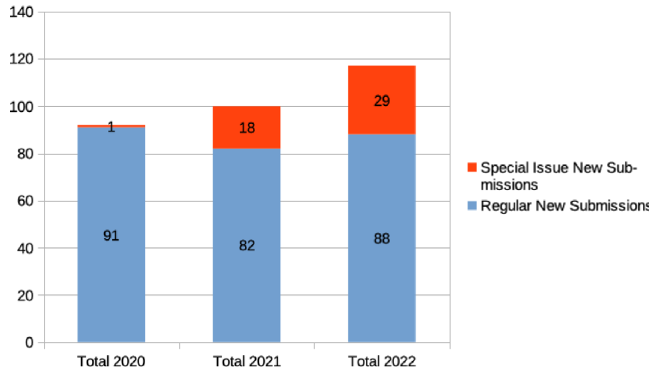
Figure 1. Number of regular submission and number of submissions to a Topical Issue .